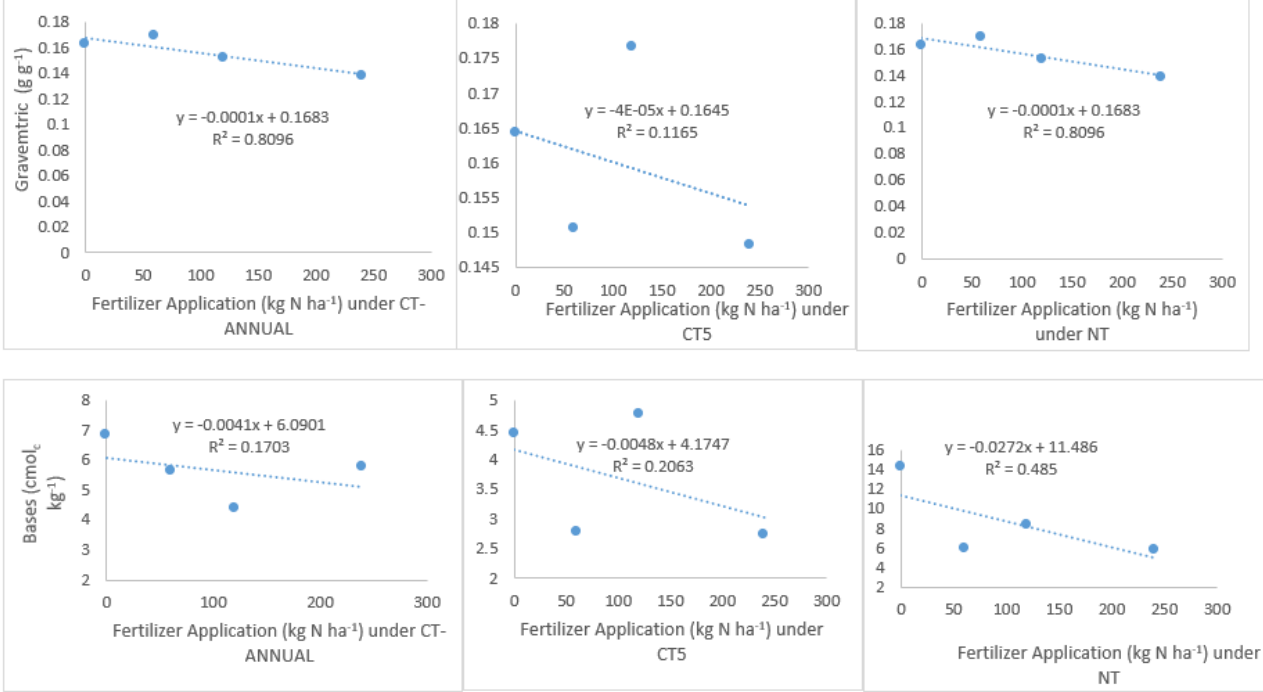
Figure 1. Relationship between fertilizer application rates under different tillage techniques and gravimetric water content and bases.